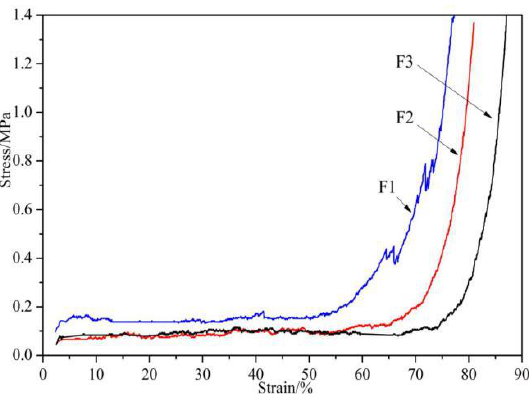
Figure 2. Compression of furanic-glyoxal foams.